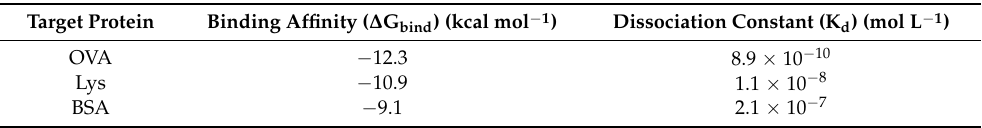
Table 1. Predicted binding affinities and dissociation constants of complexes between anti-OVA and target proteins 1 .